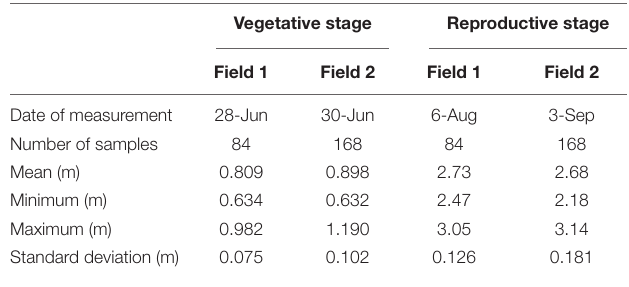
TABLE 3 | Descriptive statistics of measured